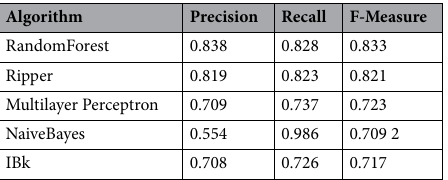
Table 2. Performance results after 10-folds cross validation on cresci-stock-2018